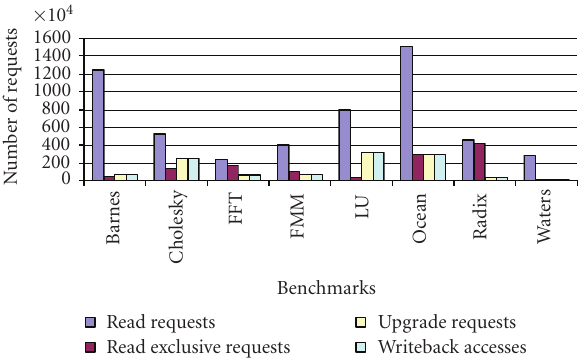
Figure 20: Comparison of number of di ff erent type of requests for splash benchmarks.